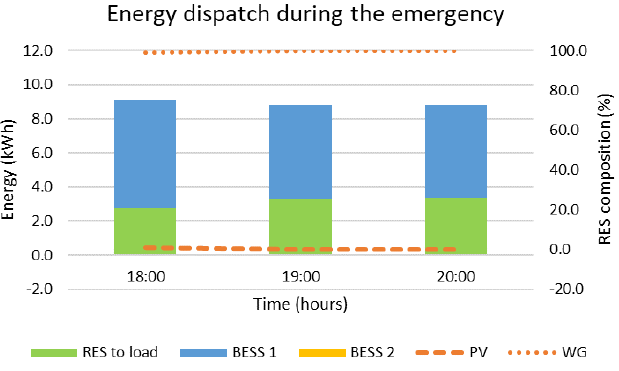
Figure 13. Energy dispatch for a black start at 18:00 followed by islanded operation until 21:00.